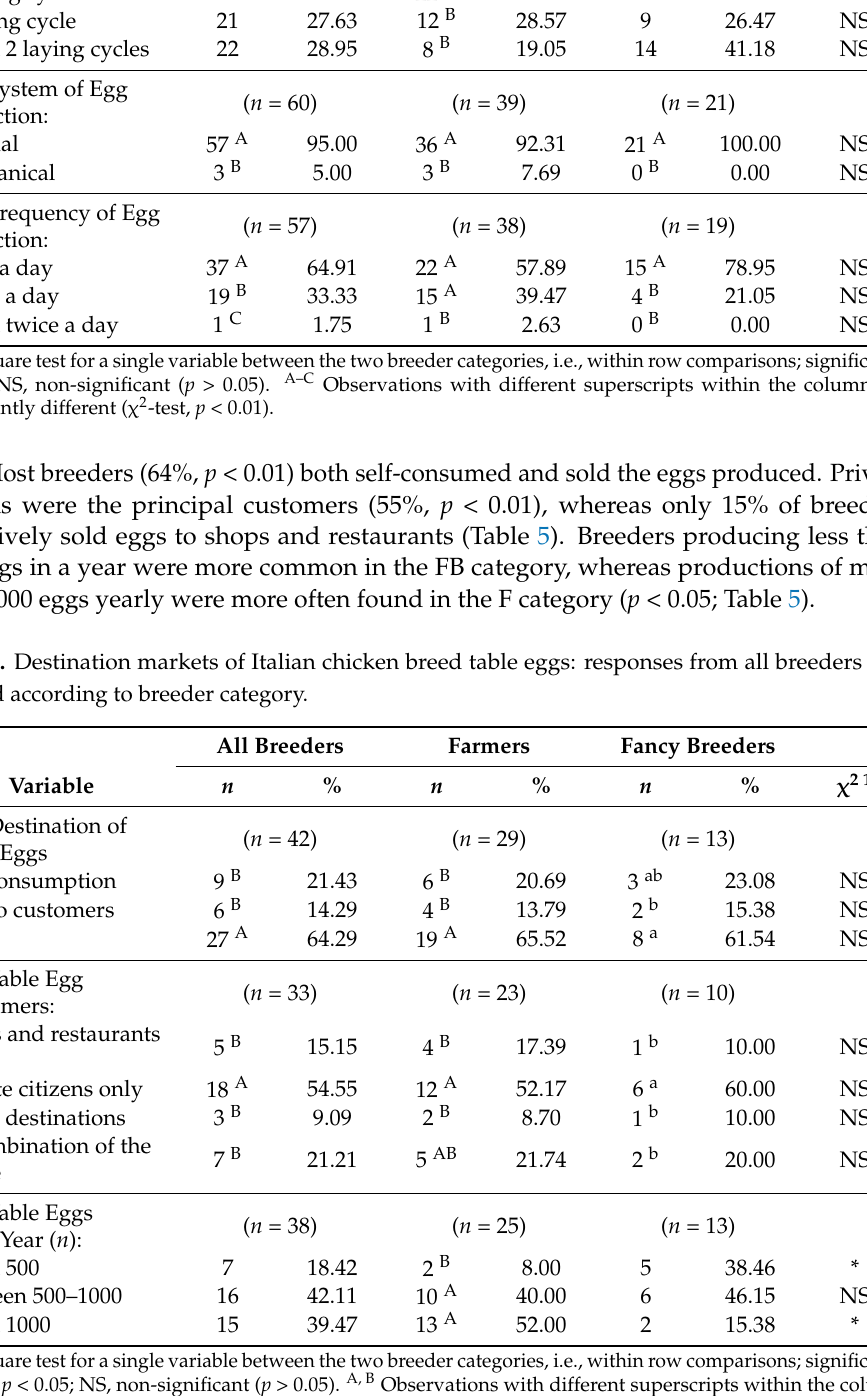
1 Chi square test for a single variable between the two breeder categories, i.e., within row comparisons; significance levels: * p < 0.05; NS, non-significant ( p > 0.05). A,B Observations with different superscripts within the column are significantly different ( χ 2 -test, p < 0.01). a,b Observations with different superscripts within the column are significantly different ( χ 2 -test, p <